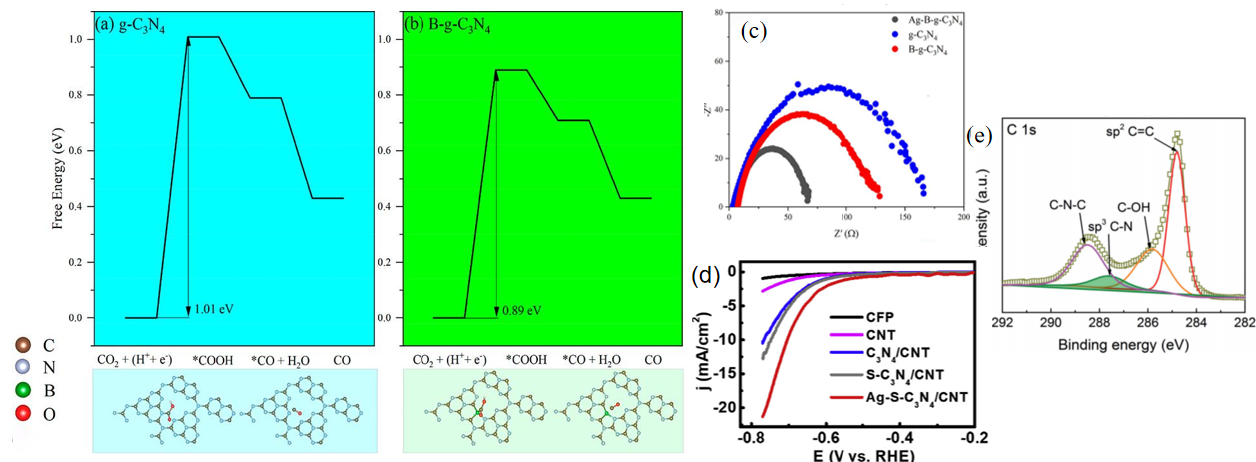
Figure 9. Calculated free energy spectrum of the electrocatalytic reduction of CO 2 to CO by ( a ) g-C 3 N 4 , ( b ) B-g-C 3 N 4 , ( c ) EIS diagram of g-C 3 N 4 , B-g-C 3 N 4 , and Ag-B-g-C 3 N 4 catalysts at − 0.8 V vs.